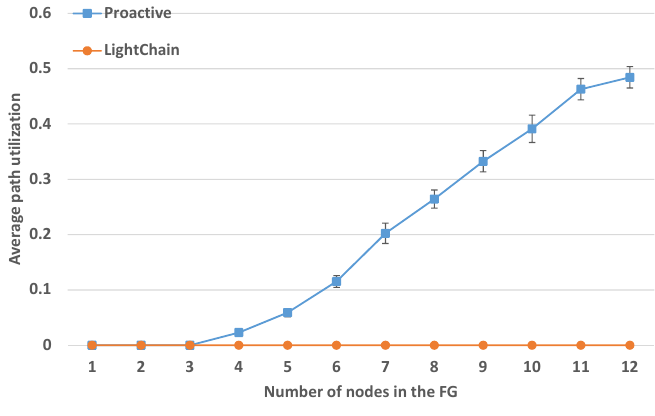
Figure 12. Average path utilization for increased FG size.